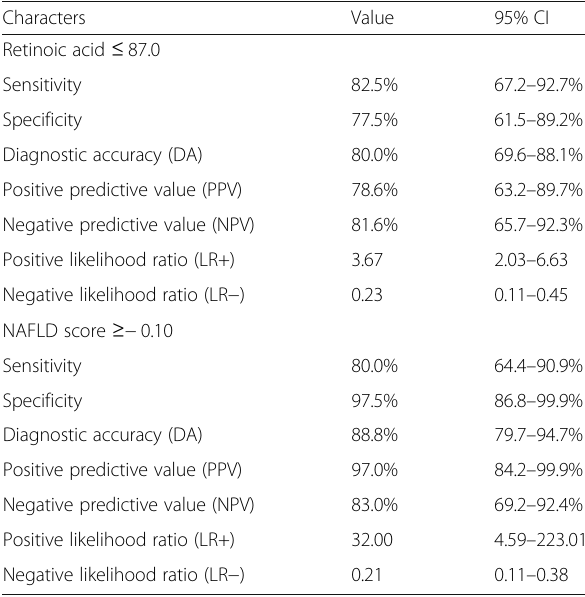
Table 6 Diagnostic characteristics of retinoic acid and NAFLD score in differentiating group 1 from group